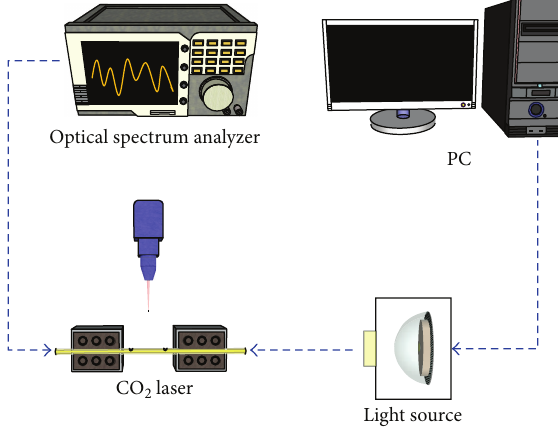
Figure 3: Schematic of FO-MZI production process with CO 2 laser.